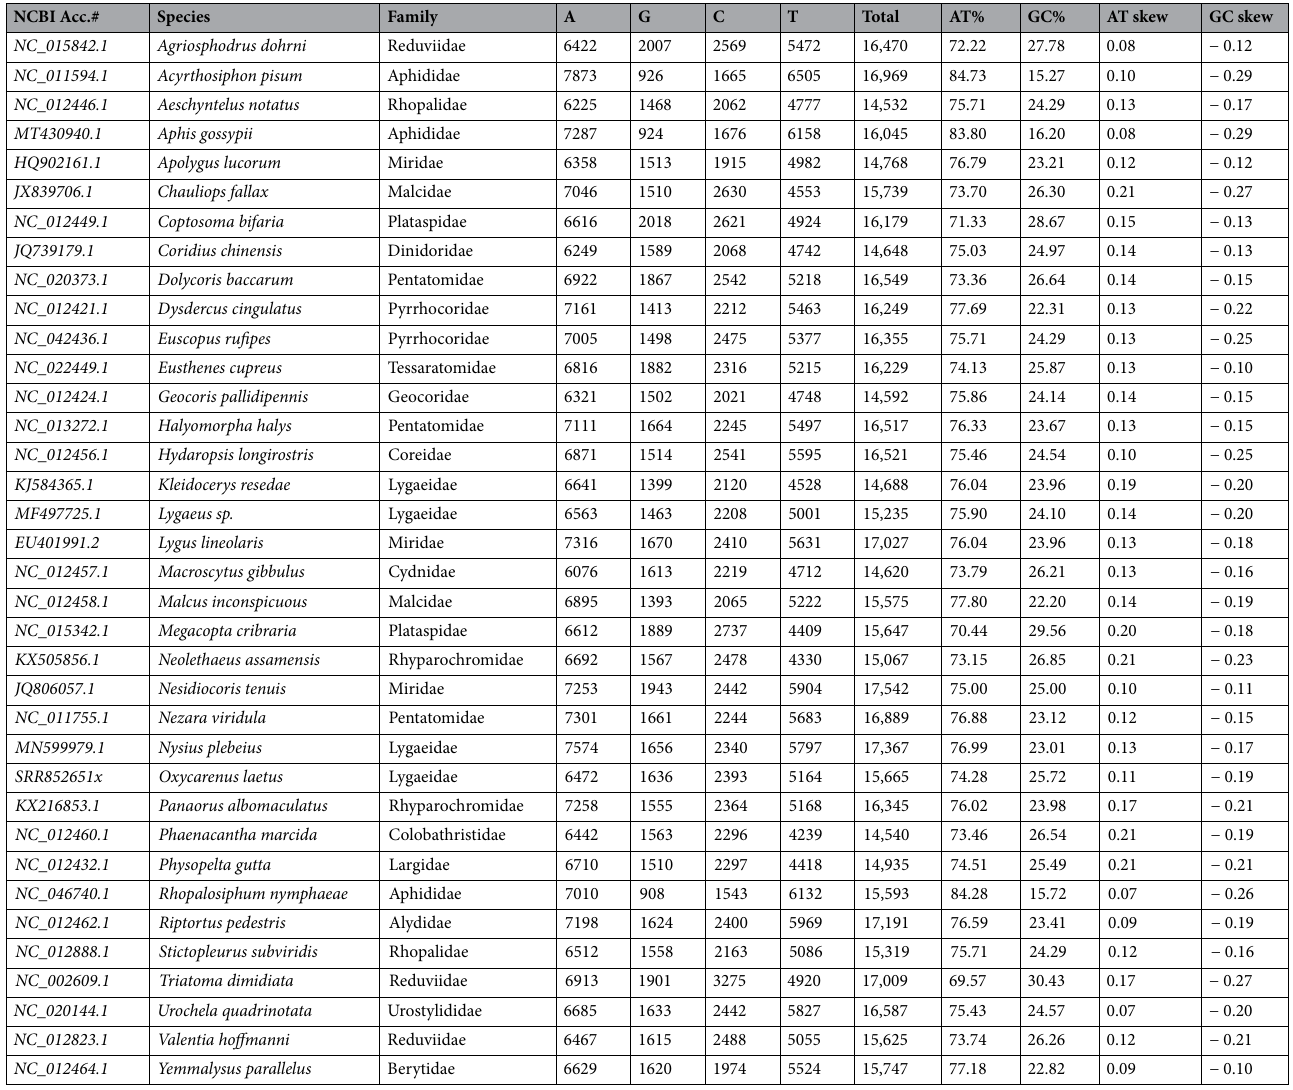
Table 3. Comparison of skewness in other insect